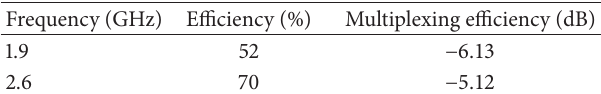
Table 2: Antenna